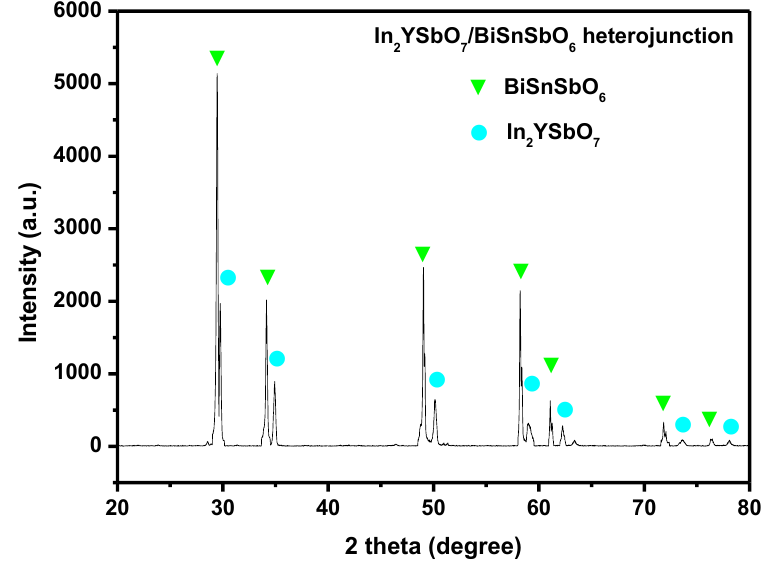
Figure 4. The XRD spectrum of In 2 YSbO 7 /BiSnSbO 6 heterojunction.